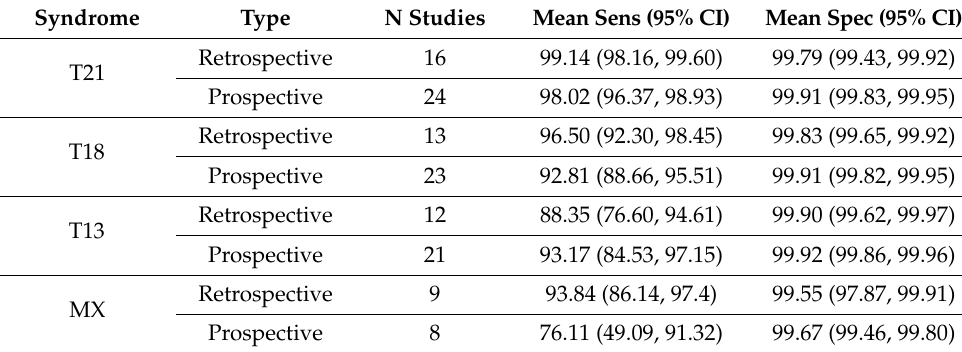
Table 5. Validation studies: summary estimates for Sensitivity (Sens) and Specificity (Spec) from bivariate model, by syndrome and study